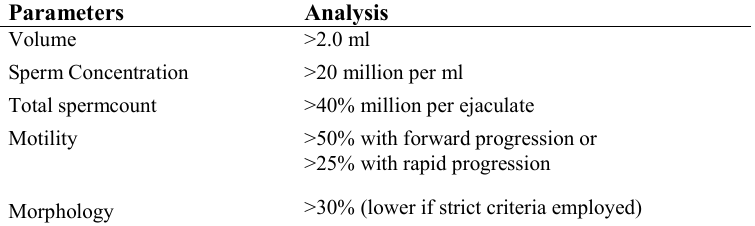
Table 1. Standard semen parameters analysis according to WHO.